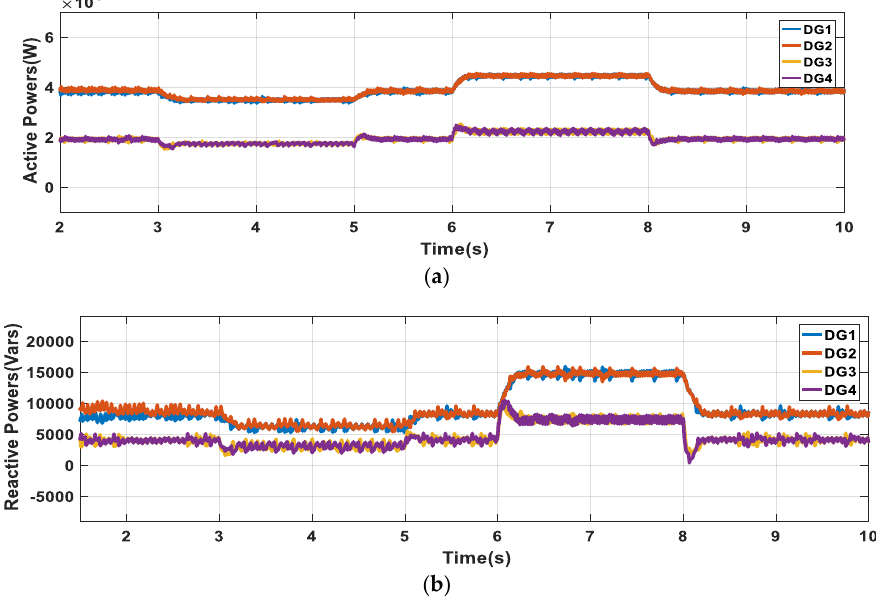
Figure 12. Output power of 4 DGs for random load change: ( a ) active power and ( b ) reactive power.